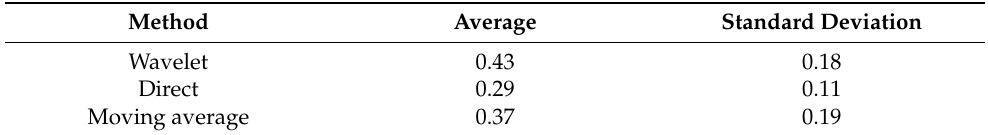
Table 6. SOC parameters: capacity = 330 kWh.